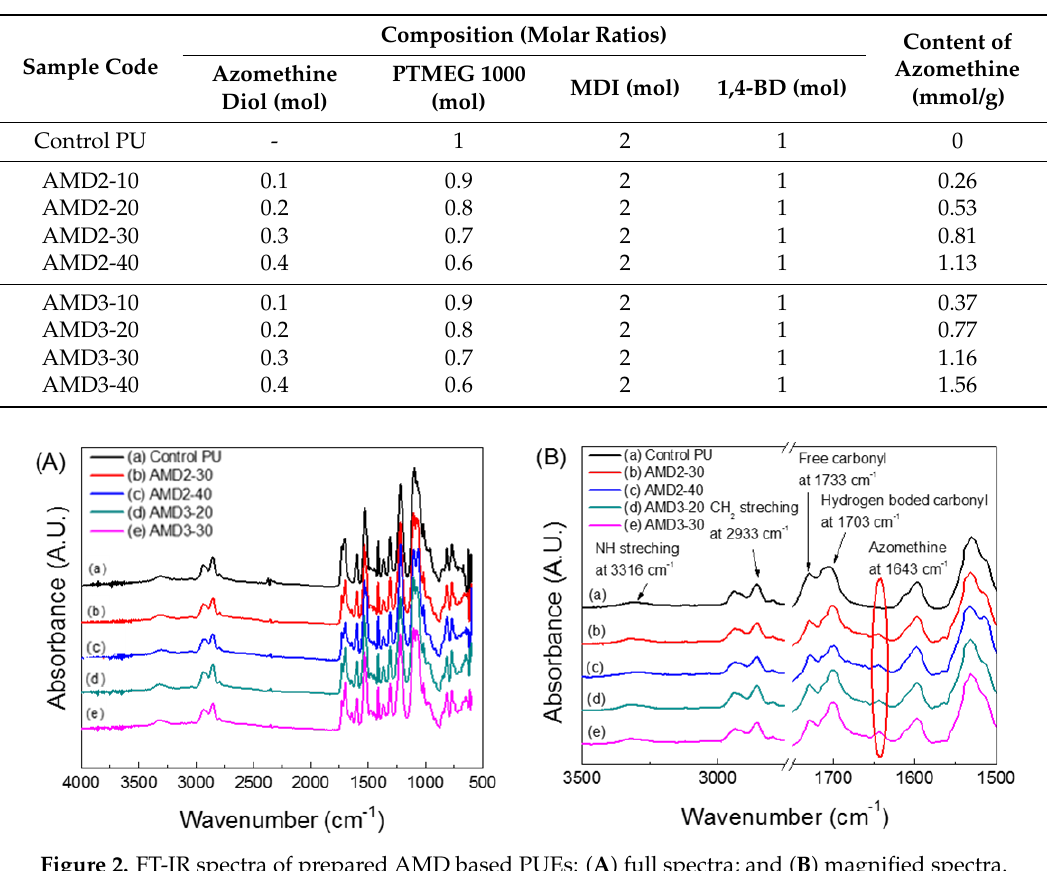
Table 1. Sample code and composition of synthesized PUEs.